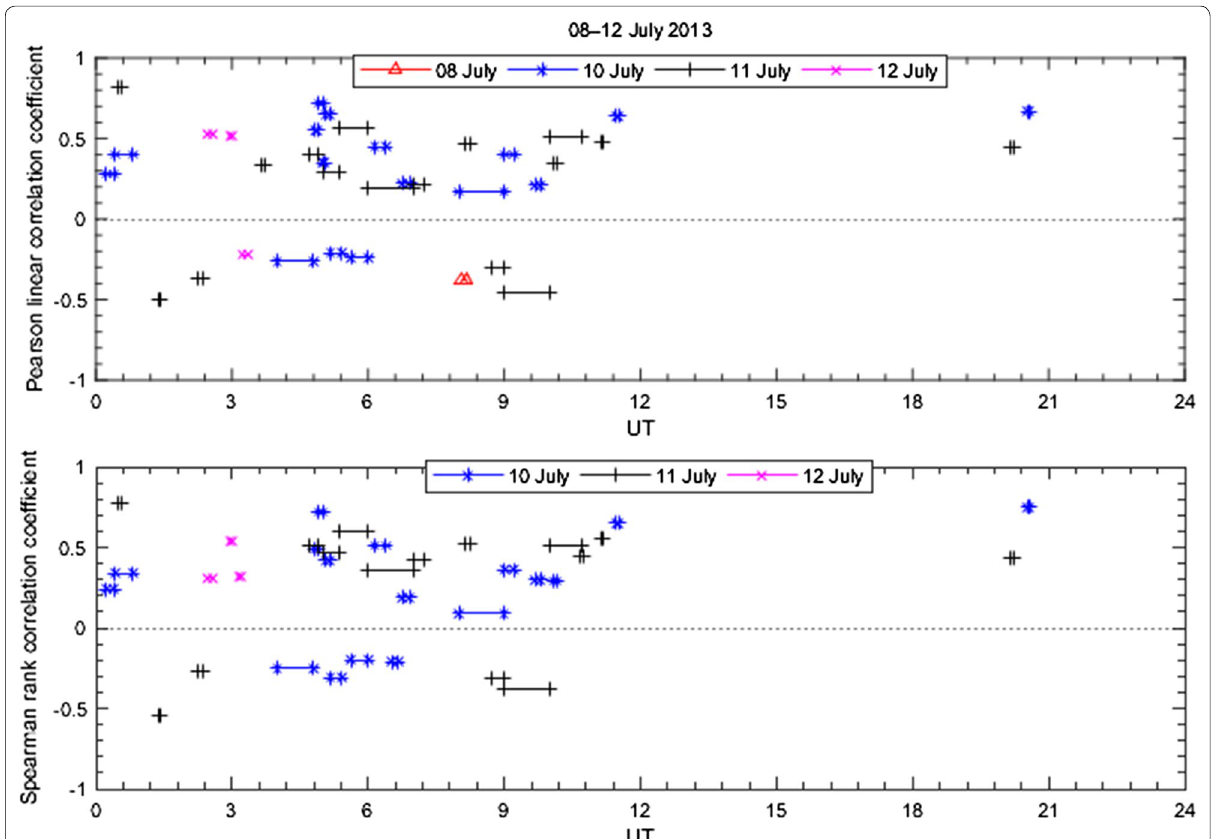
Fig. 2 Pearson linear and Spearman rank correlation coefficient computed for time intervals of various lengths ( t PMSE and particle precipitation. For each correlation coefficient, P value is less than 0.05. The horizontal dotted line is drawn to separate positive and negative correlation